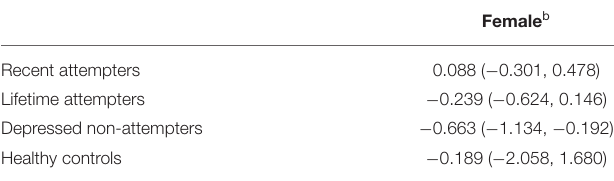
TABLE 5 | Effect sizes of being female on executive function a